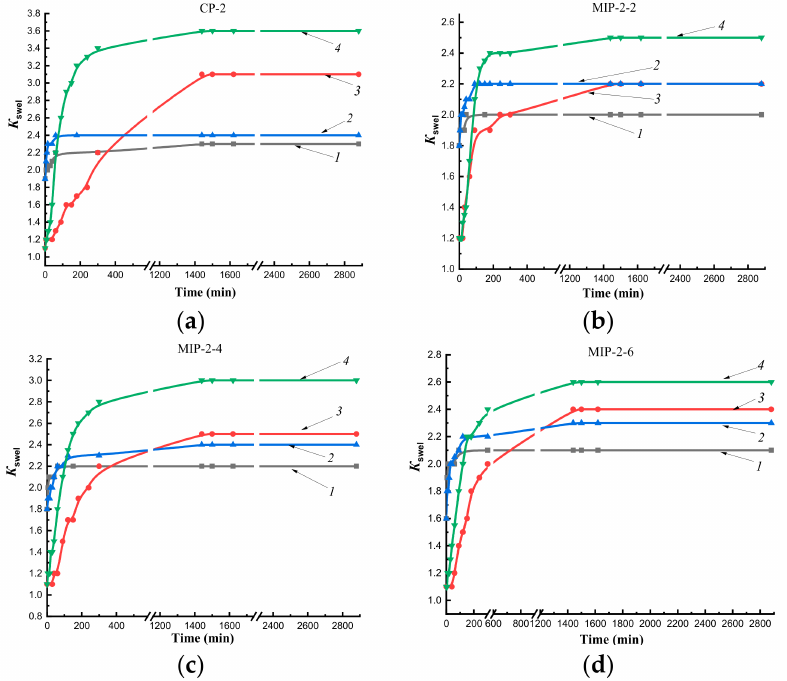
Figure 6. Kinetics of swelling sorbents obtained by Method 1 in water and n-propyl alcohol at temperatures of 25 ◦ C and 37 ◦ C: CP-2 ( a ), MIP-2-2 ( b ), MIP-2-4 ( c ), MIP-2-6 ( d ); 1 —in water at 25 ◦ C; 2 —in water at 37 ◦ C; 3 —in n-propyl alcohol at 25 ◦ C; 4 —in n-propyl alcohol at 37 ◦